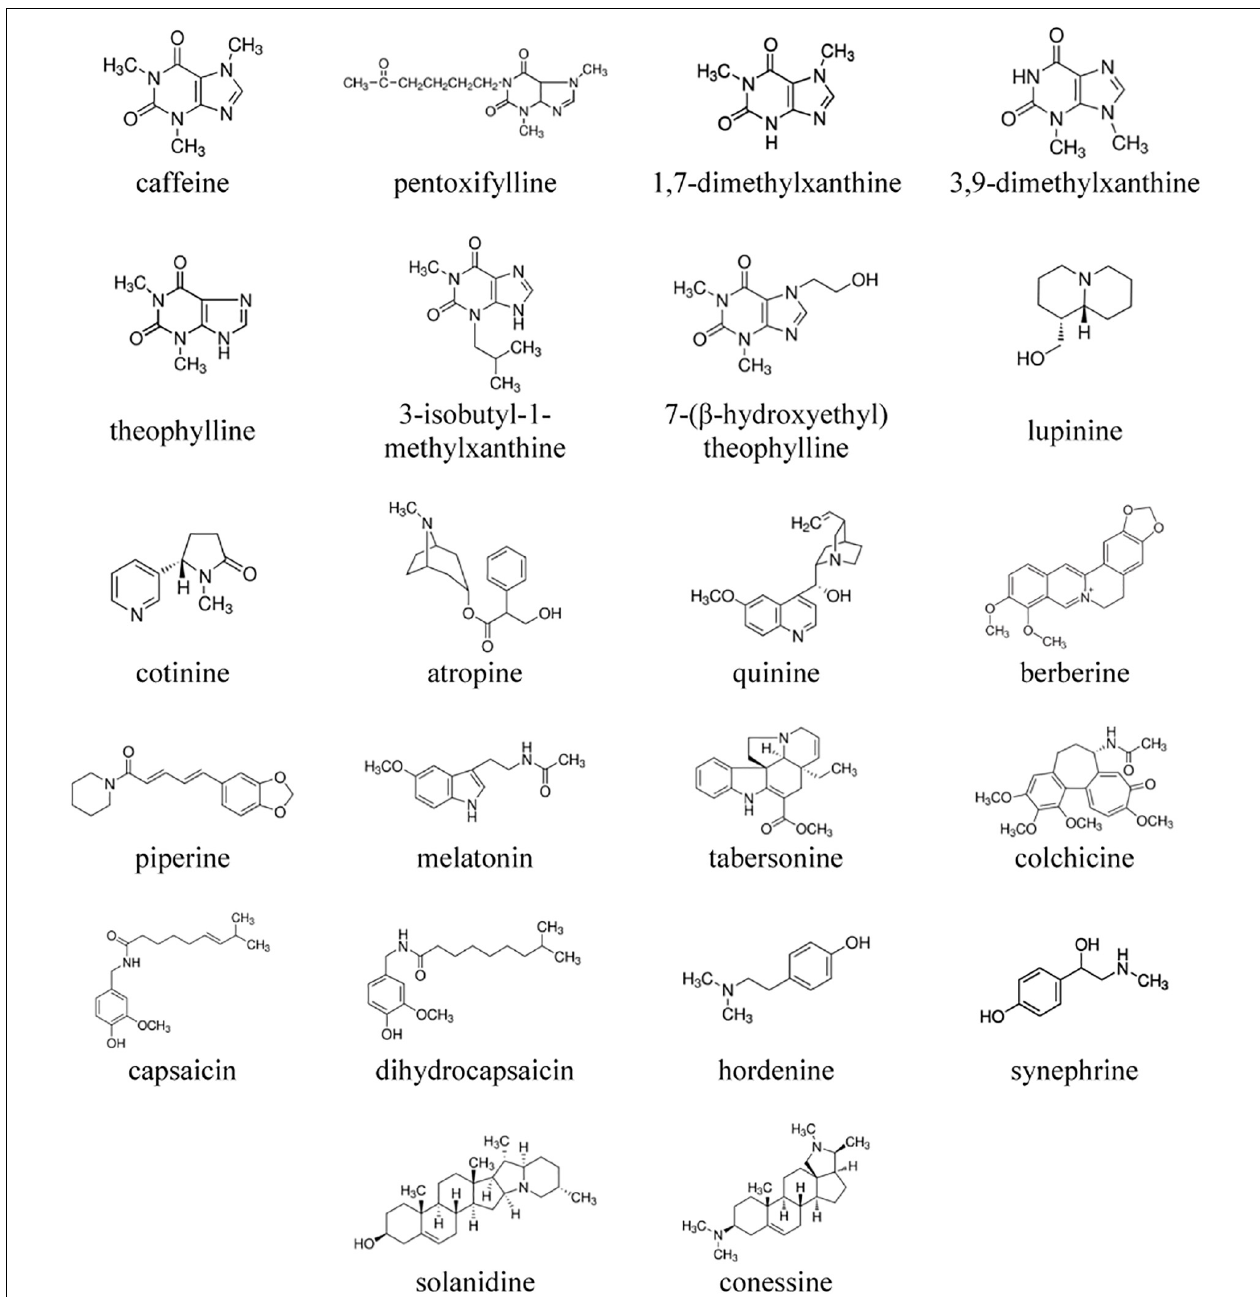
FIGURE 1 | The chemical structures of the tested alkaloids.